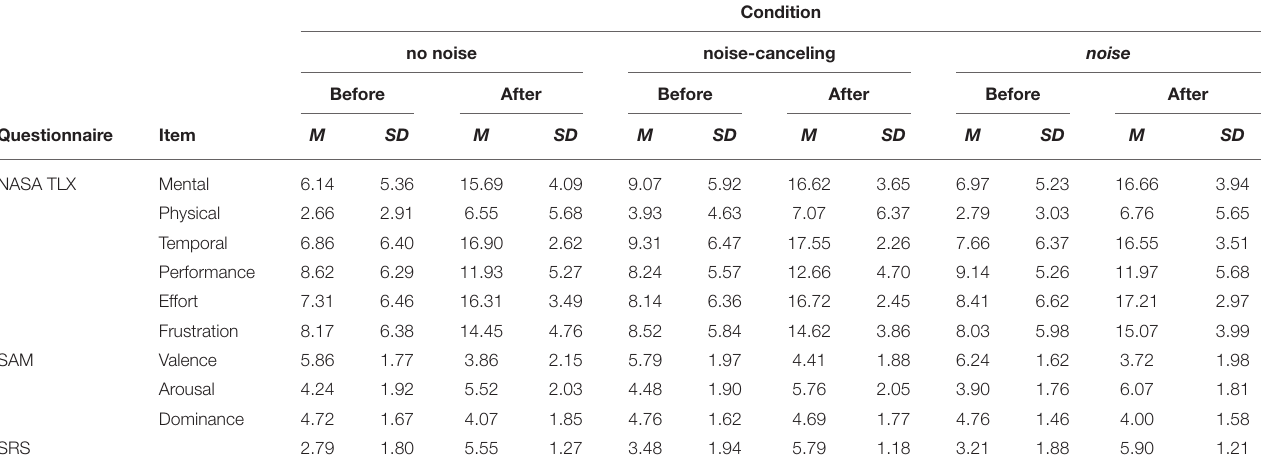
TABLE 1 | Mean and standard deviation of subjective measure ratings before and after the performed task. Condition no noise noise-canceling noise Before After Before After Before